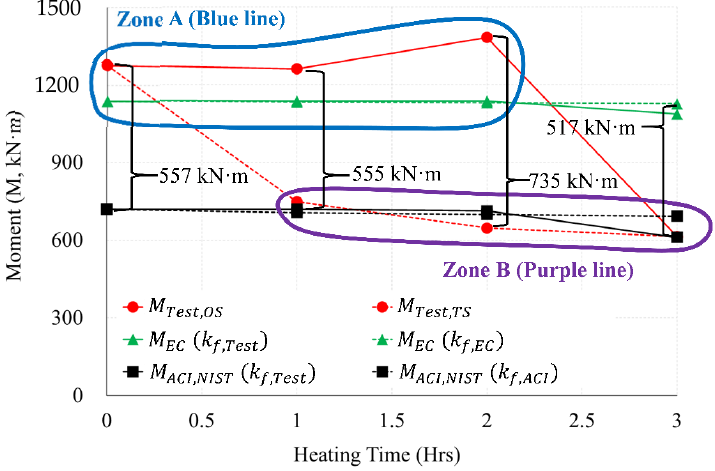
Figure 22. Comparison of load results by test (OS, TS) and Standard (EN1992-1-2, ACI 216.1M-14 and NIST 1681).